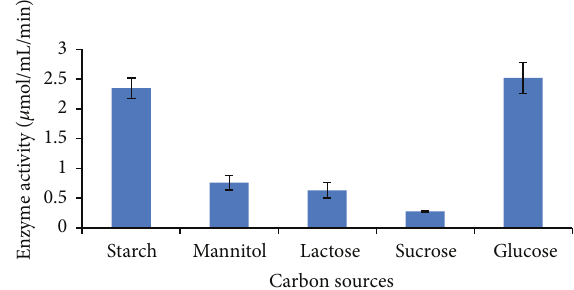
Figure 5: L-asparaginase production by Streptomyces ginsengisoli grown in asparagine dextrose salt broth amended with different carbon sources.